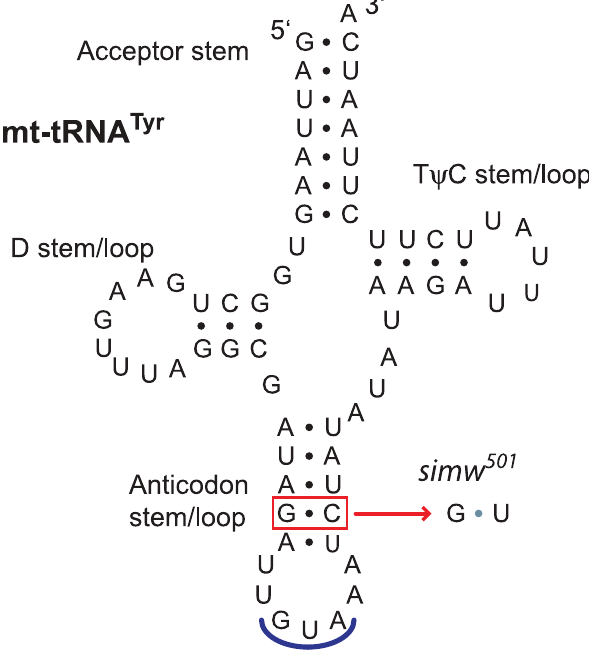
Figure 3. A mtDNA polymorphism in the D.simulans mt-tRNA Tyr anticodon stem. The D. simulans simw 501 tRNA Tyr has a G:C to G:U mutation in the anticodon stem relative to the D. simulans sm21 and D. melanogaster mtDNAs. Shown is the D. simulans sm21 sequence.